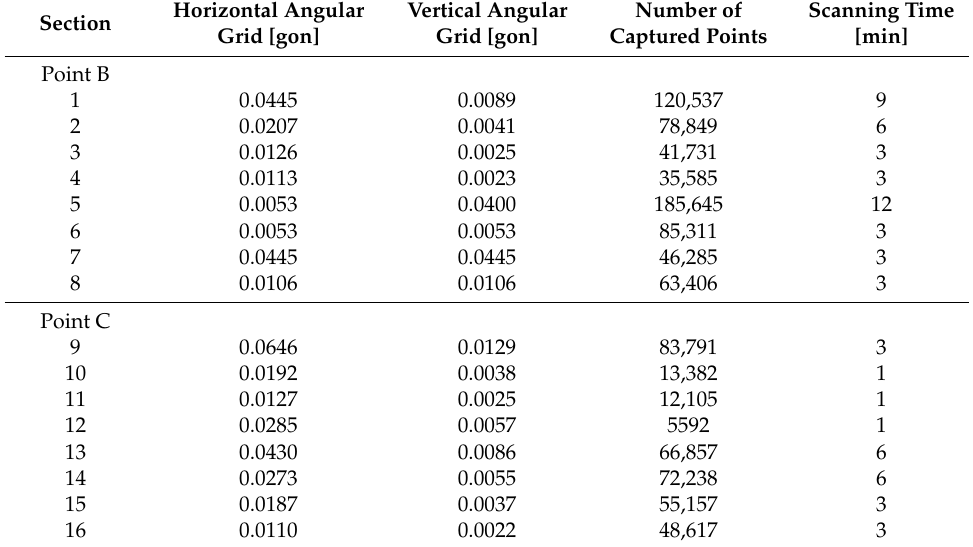
Table 3. The horizontal and vertical angular scanning grid, the number of captured points on an individual section, and the time necessary to capture the points on an individual